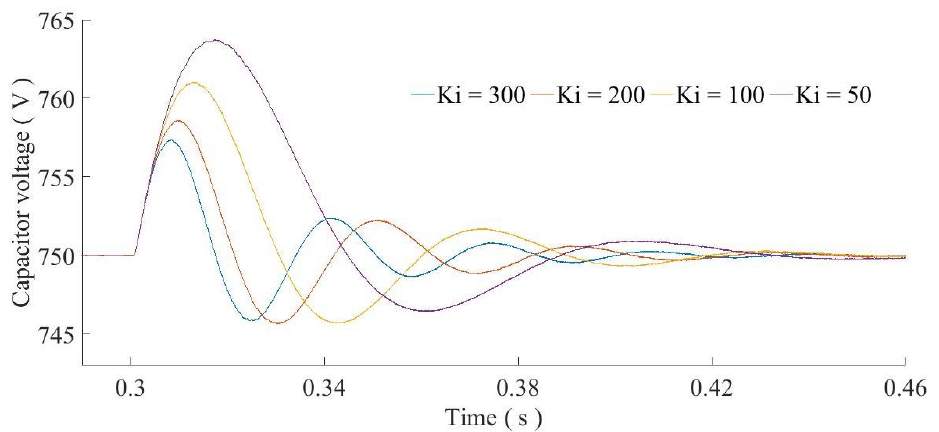
Figure 12. Influence of K i on dynamic performance of the DDPS.